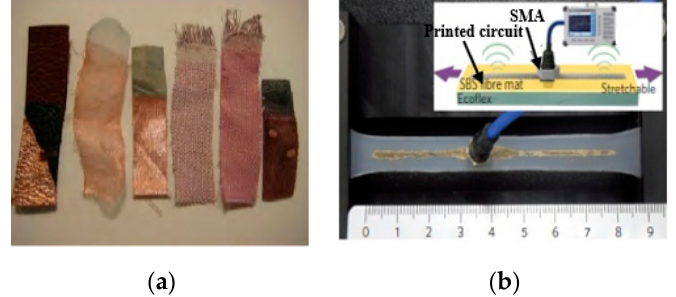
Figure 1. ( a ) Different conductive textile material [96], ( b ) conductive composite materials [135].